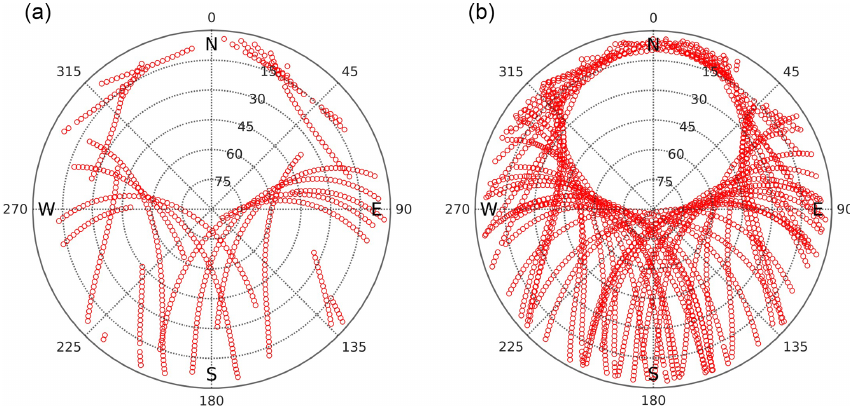
Figure 3. Sky plots of GPS observations at Onsala from 06:00 to 12:00UT (a) and from 00:00 to 24:00UT (b) on 12 May 2014. This particular day was chosen because it is included in the CONT14 campaign presented in Sect. 5.3. The sky distribution of observations is very similar, although not identical, for all